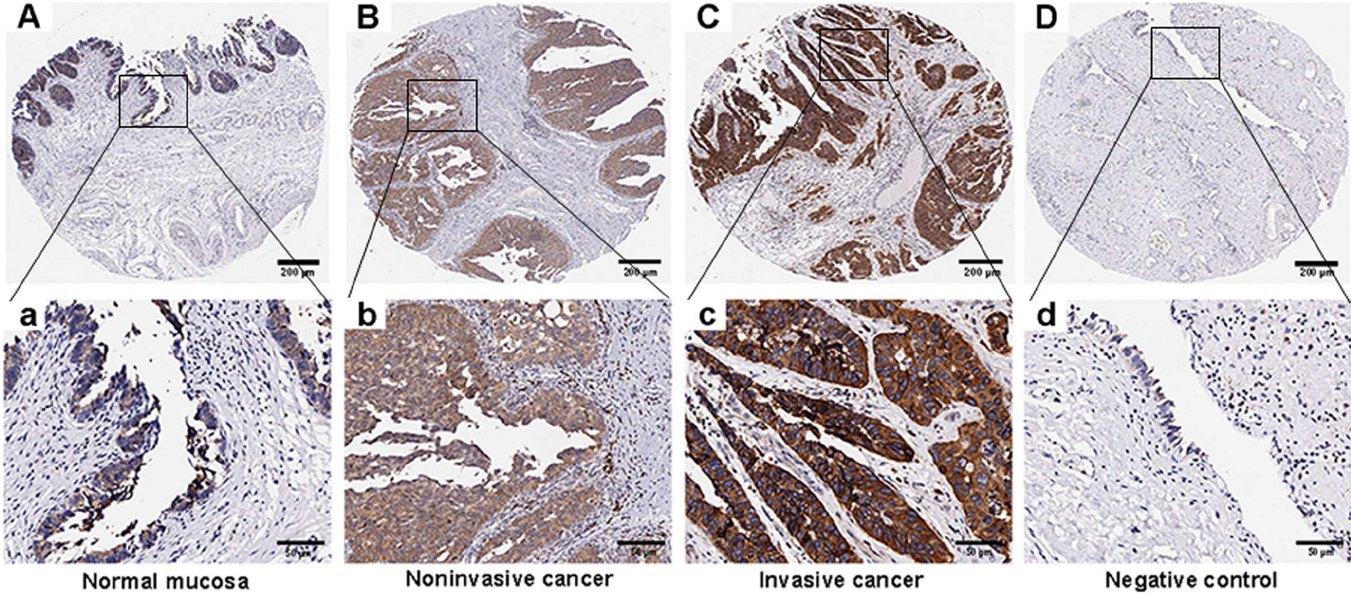
Fig 1. Representative images of Derlin-1 protein expressionin IHC microarrays. (A and a), normalmucosa; (B and b), noninvasive cancer; (C and c), invasivecancer; (D and d), negativecontrol; IHC = immunohistochemistry (A, B, C and D, magnification × 40, scale bars: 200 μ m; a, b, c and d, magnification × 200, scale bars: 50 μ